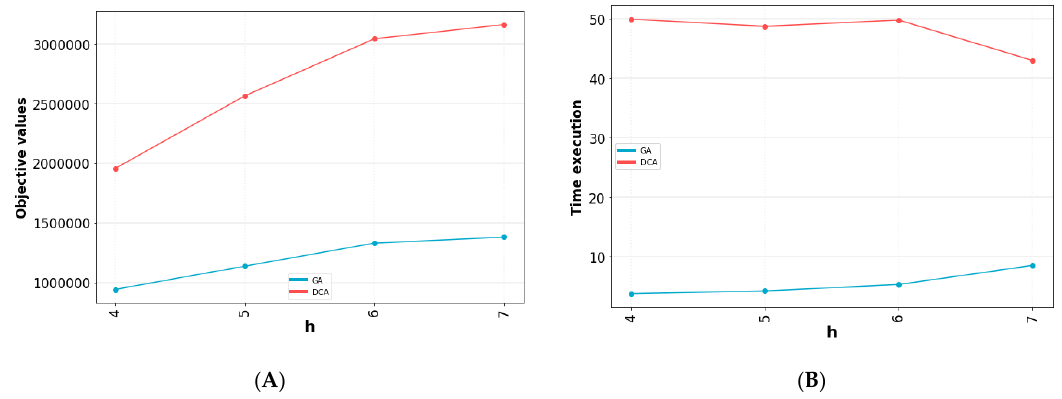
Figure 16. ( A ) the objective values of the algorithms with different team size; ( B ) the execution time of the algorithms with different team size.